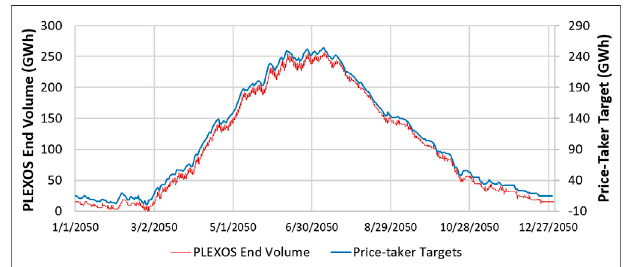
FIGURE 8 | Price-taker targets and PLEXOS ST energy storage end volumescomparisonfora2,000 MW,40%round-tripef fi ciency,and1-month duration energy storage device in 2050.